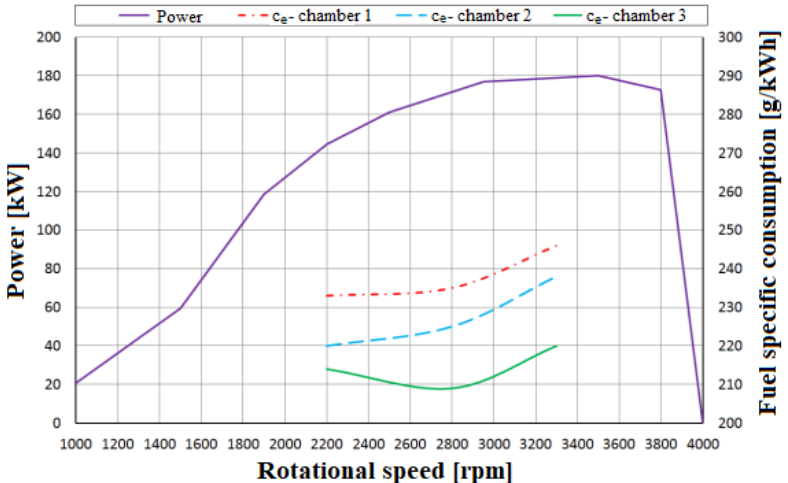
Figure 32. Comparison of the minimum fuel specific consumption between the three combustion chambers.